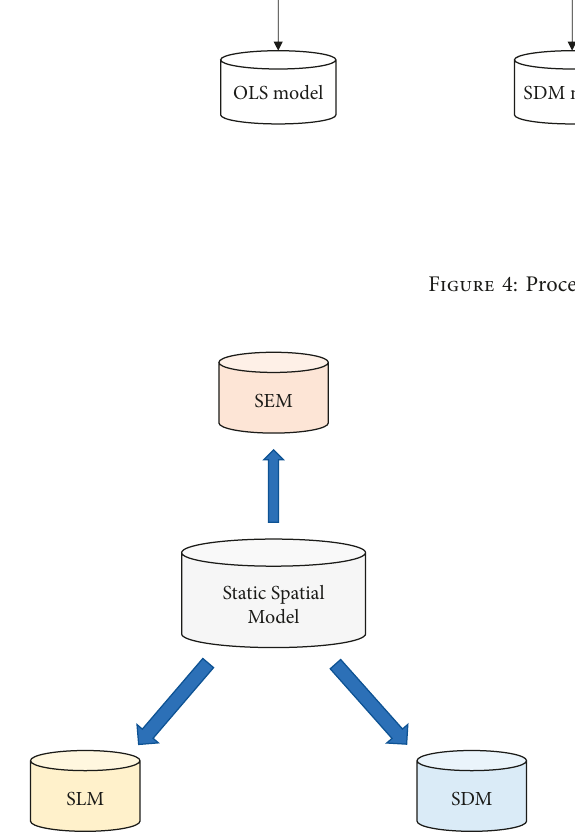
Figure 5: Various static spatial Table 2: Result of spatial Durbin model. Road